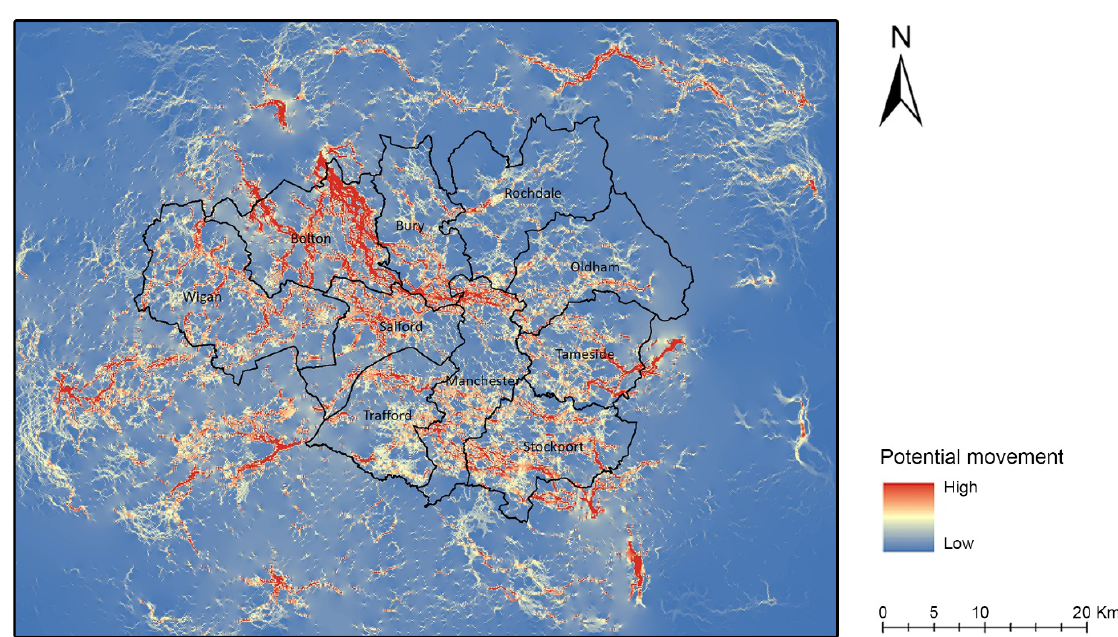
Figure 7. The flows of active migration based on the intensity of human modification. specific dispersal agent. Nevertheless, this method could be complemented with species-specific models for tree species with specialised habitat